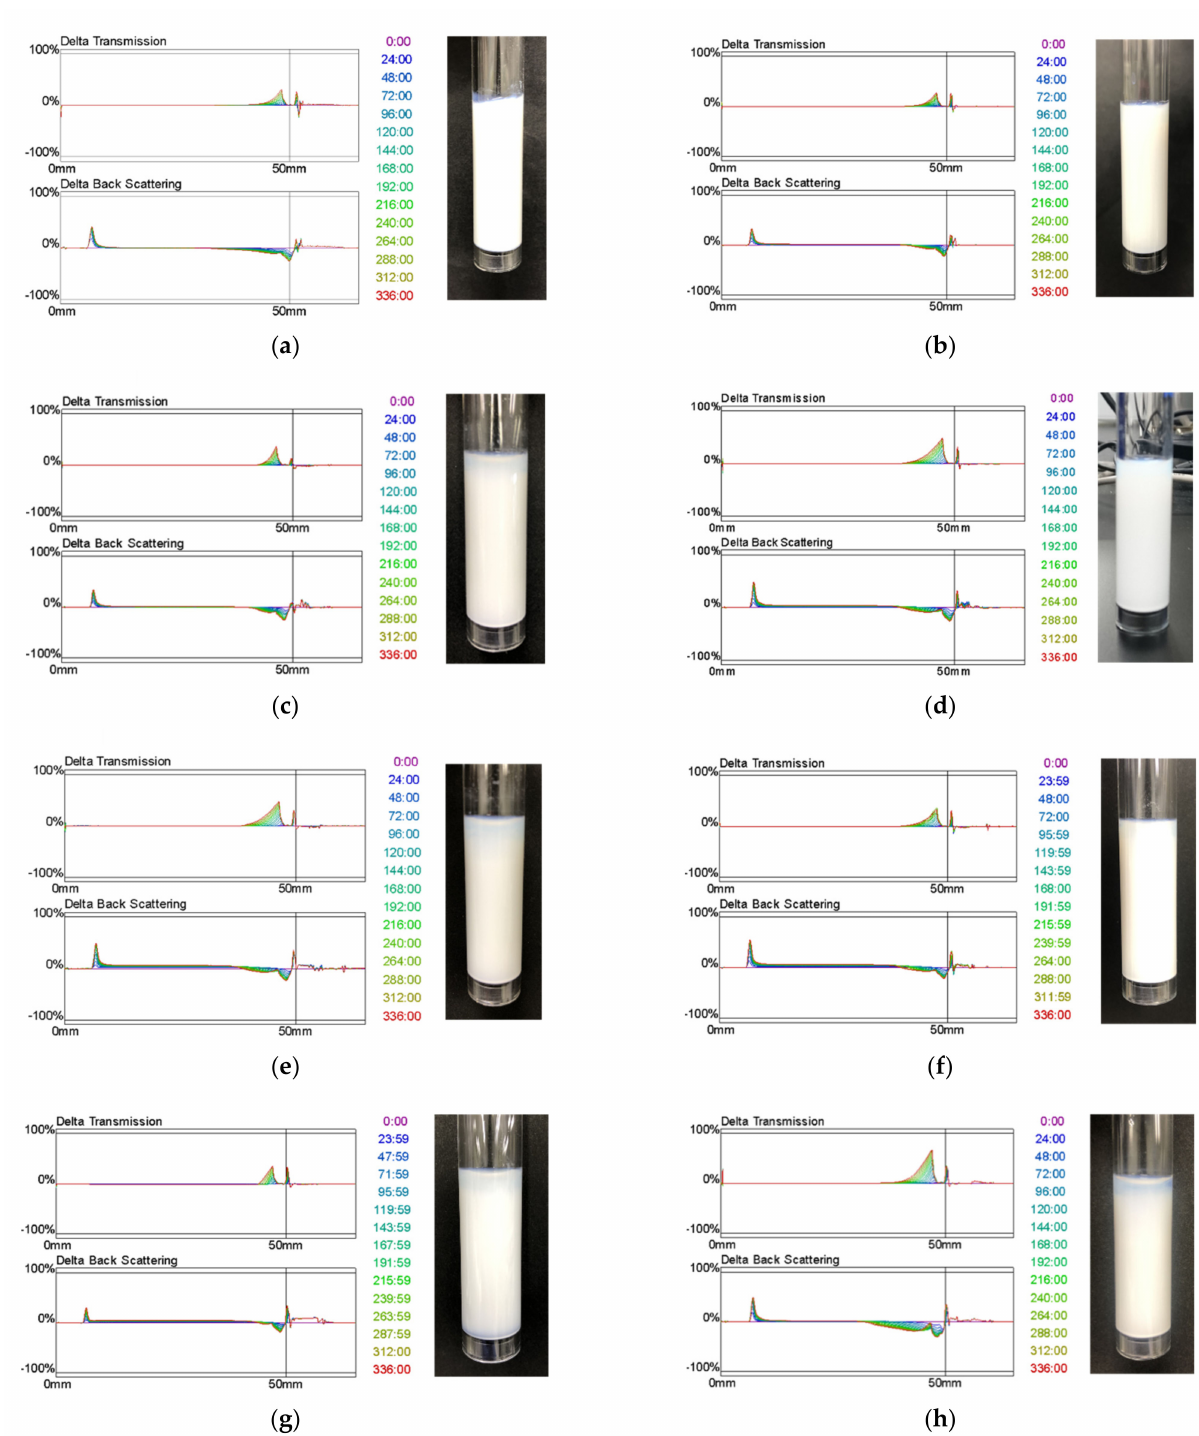
Figure 6. Transmission and backscattering patterns of various suspensions. ( a ) F1, ( b ) F2, ( c )